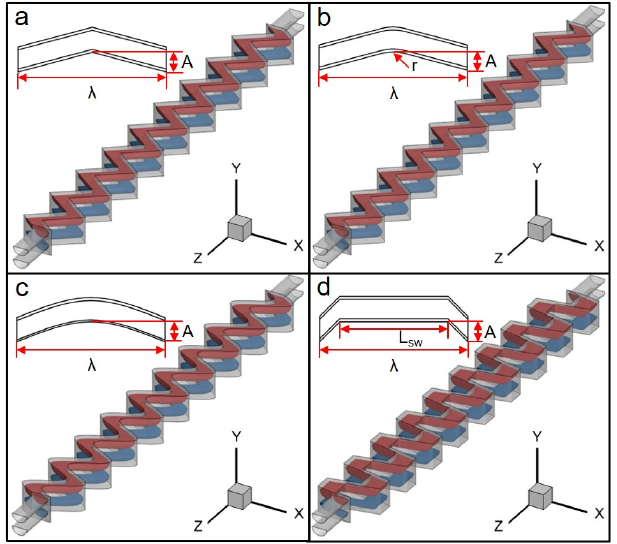
Figure 2. Computational domain of the four wavy channels. ( a ) Zigzag channel; ( b ) Fillet channel; ( c ) Sinusoidal channel (Sin channel); ( d ) Trapezoidal channel (Trape channel). Insert: top view of the wavy channel in a half period. Table 1. Detailed geometry coefficients of the four wavy channels. All length units are in mm.